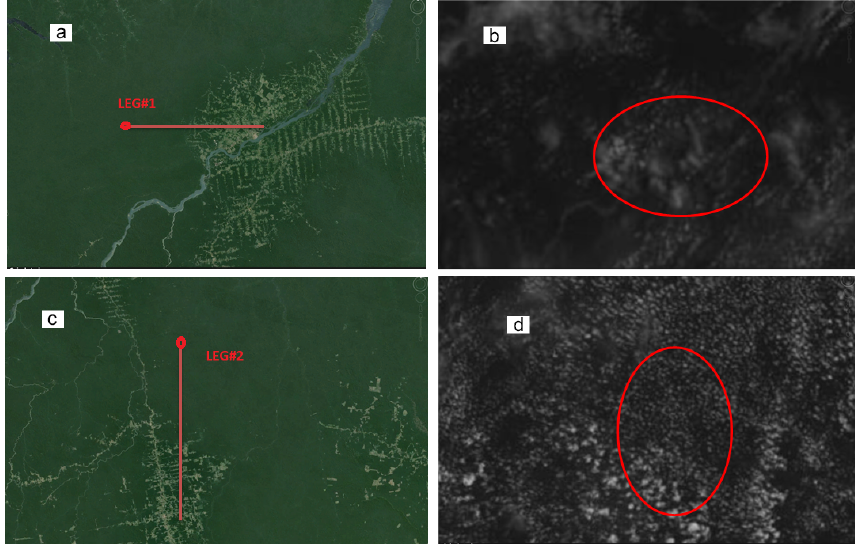
Figure 10. AC17 flight paths over forested and deforested regions. Flight legs 1 and 2 are shown in red in (a) and (c) , respectively (sourced from Google Earth). The dot on flight leg 1 corresponds to 56 ◦ 57 (cid:48) W, 4 ◦ 13 (cid:48) S and that on flight leg 2 corresponds to 55 ◦ 17 (cid:48) W, 5 ◦ 53 (cid:48) S. Visible GOES-13 images for flight legs 1 and 2 at the time of each flight are shown in (b) and (d) , respectively.